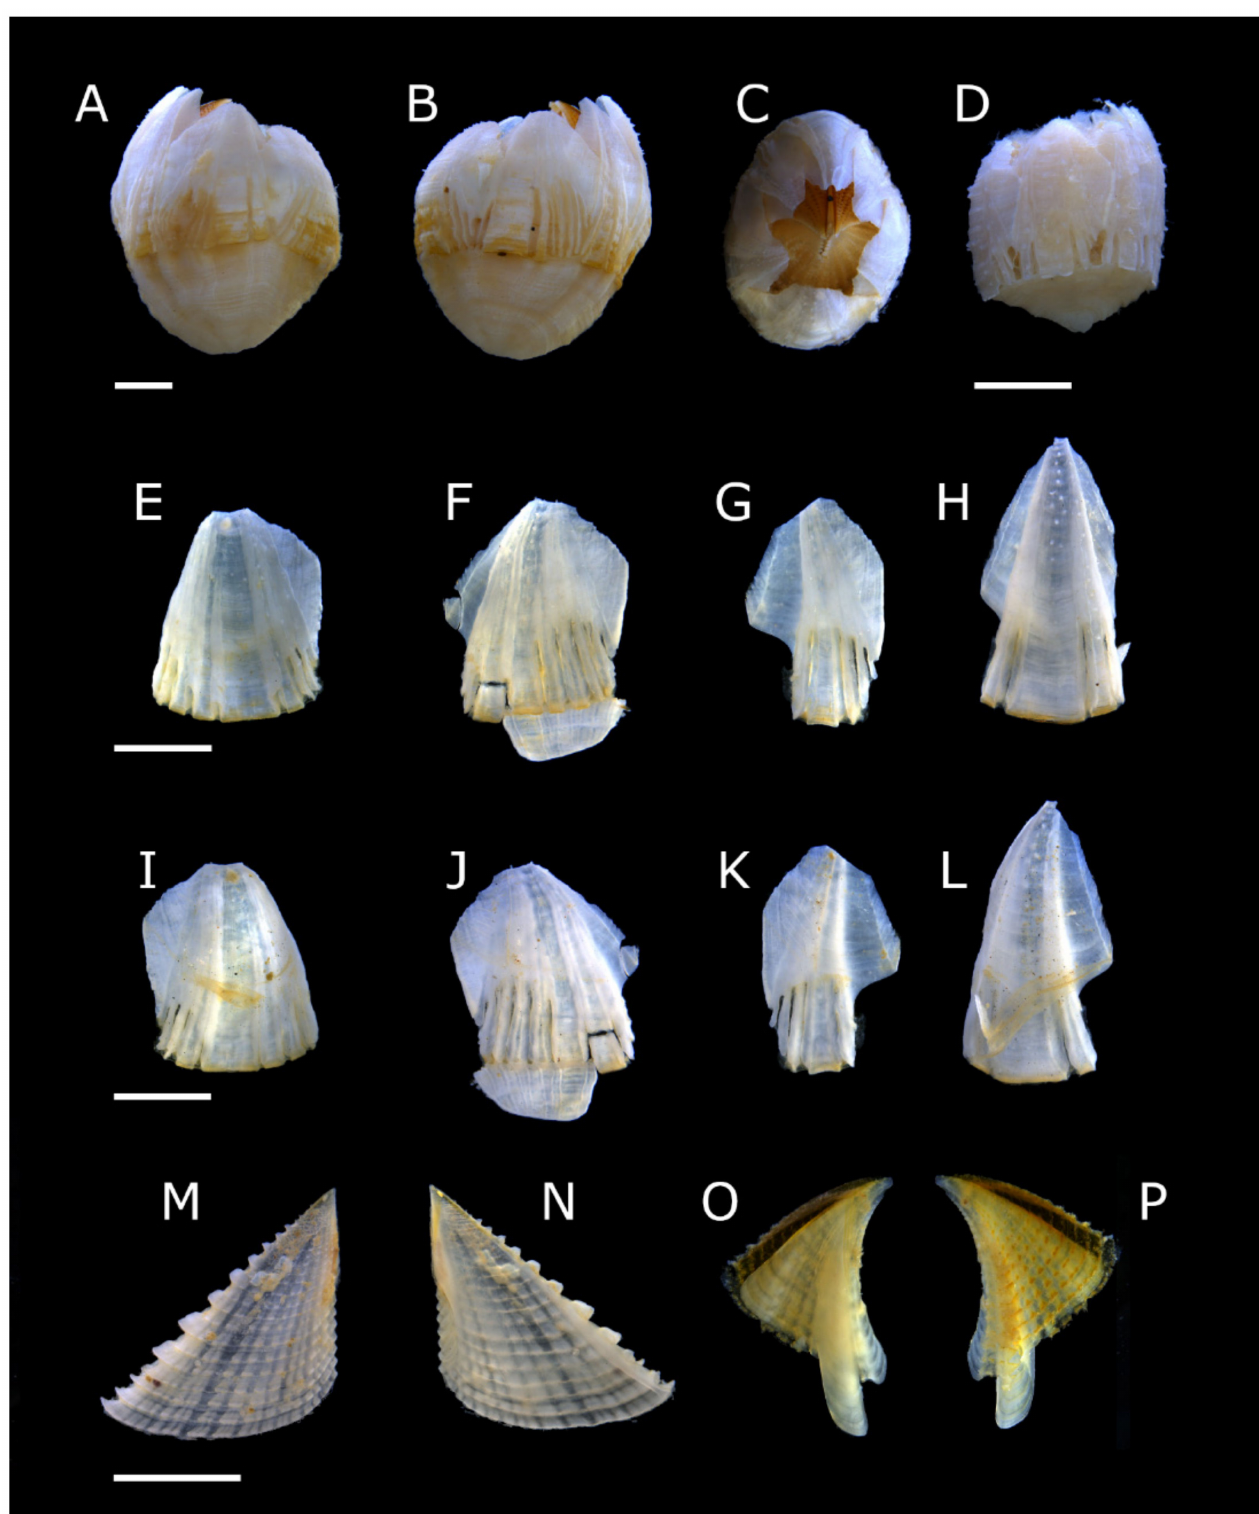
Figure 25. Pectinoacasta sculpturata (Broch, 1931) shell and shell plates (A–C, holotype ZMUC CRU9003; D, ZMUC CRU9003; E–L, ZMUC CRU9003; M–P, WAM C61395). ( A – D ) left, right and top views, respectively, of whole specimens; ( E – H ) external views of disarticulated rostrum, right latus, right carinolatus and carina; ( I – L ) internal views of same; ( M , N ) external and internal views of right scutum; ( O , P ) internal and external views of right tergum. Scale Bars: A–P = 2